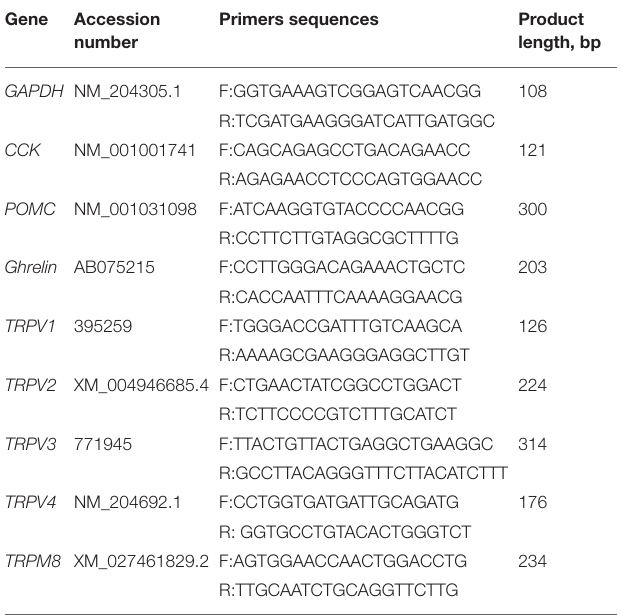
TABLE 2 | Specific gene primers used for real-time quantitative